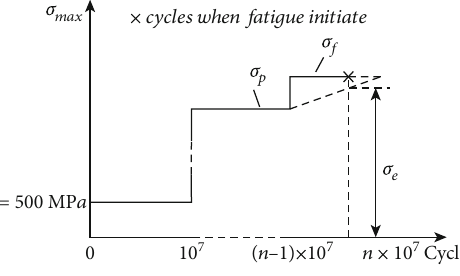
Figure 5: Load spectrum for HCF